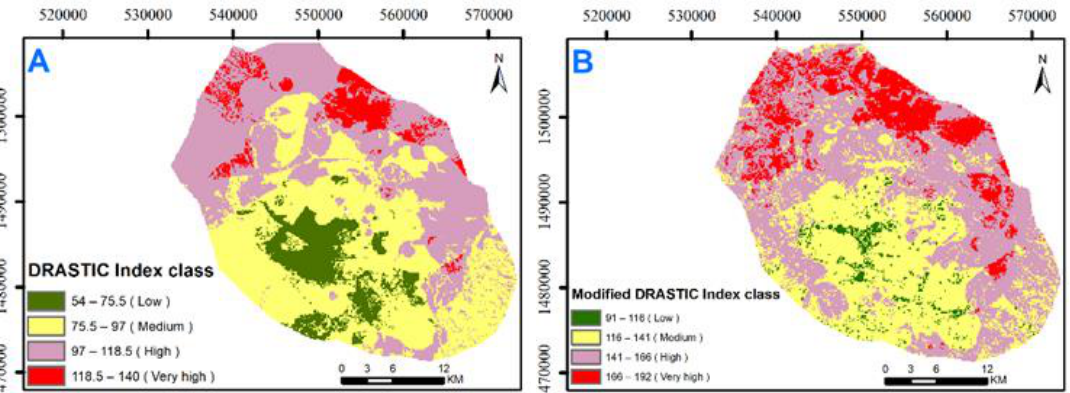
Figure 6. Vulnerability index maps of the study area using the DRASTIC ( A ), and the modified DRASTIC ( B ) methods.